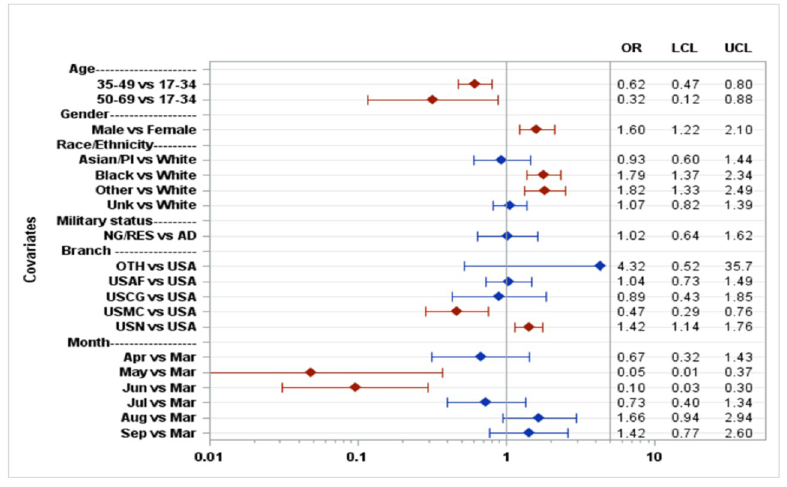
Fig 5. Adjusted ORs for positivity based on all active duty service member test case-control sample.